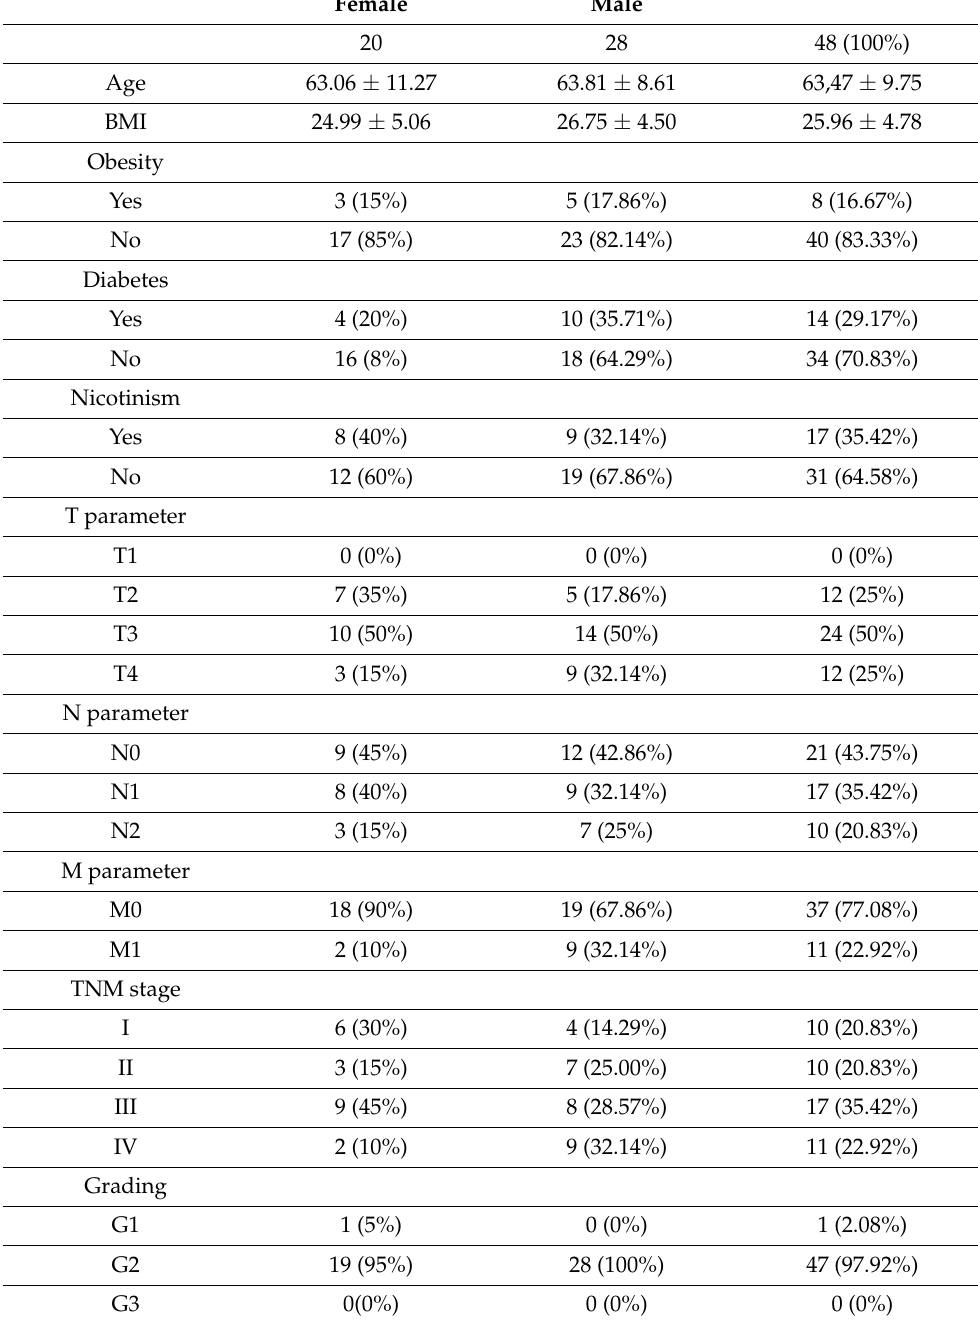
Table 1. Characteristics of the study